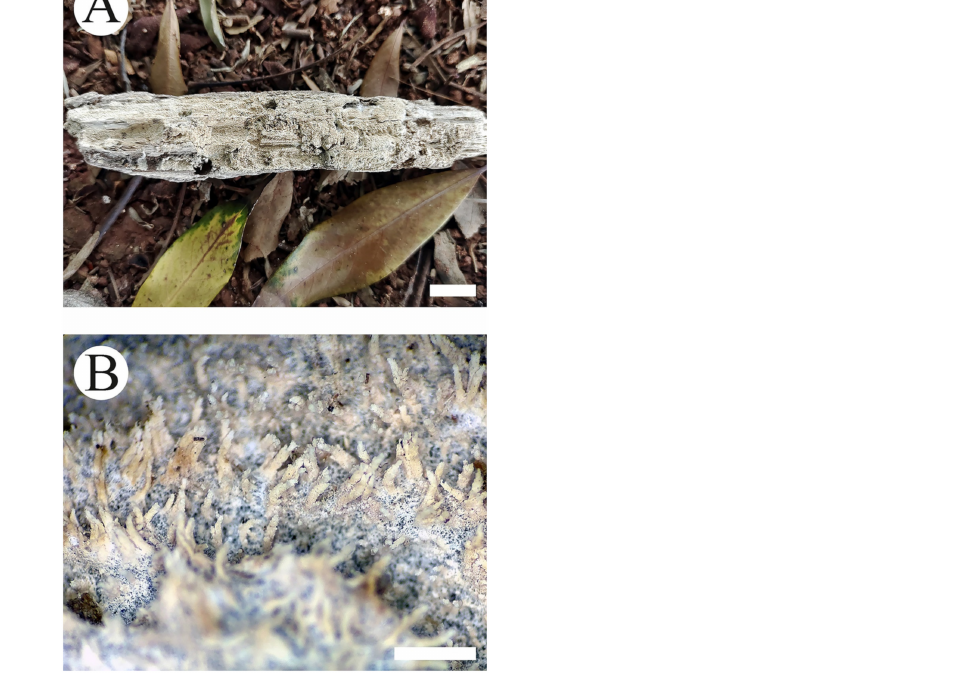
Figure 5. Basidiomata of Trechispora odontioidea (holotype CLZhao 17890): the front of the basid- iomata ( A ), characteristic hymenophore ( B ). Bars: ( A ) = 1 cm and ( B ) = 1 mm.